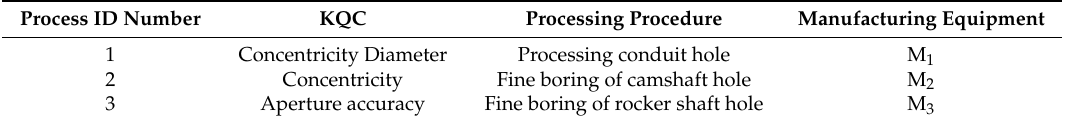
Table 1. Machining process of the cylinder head of